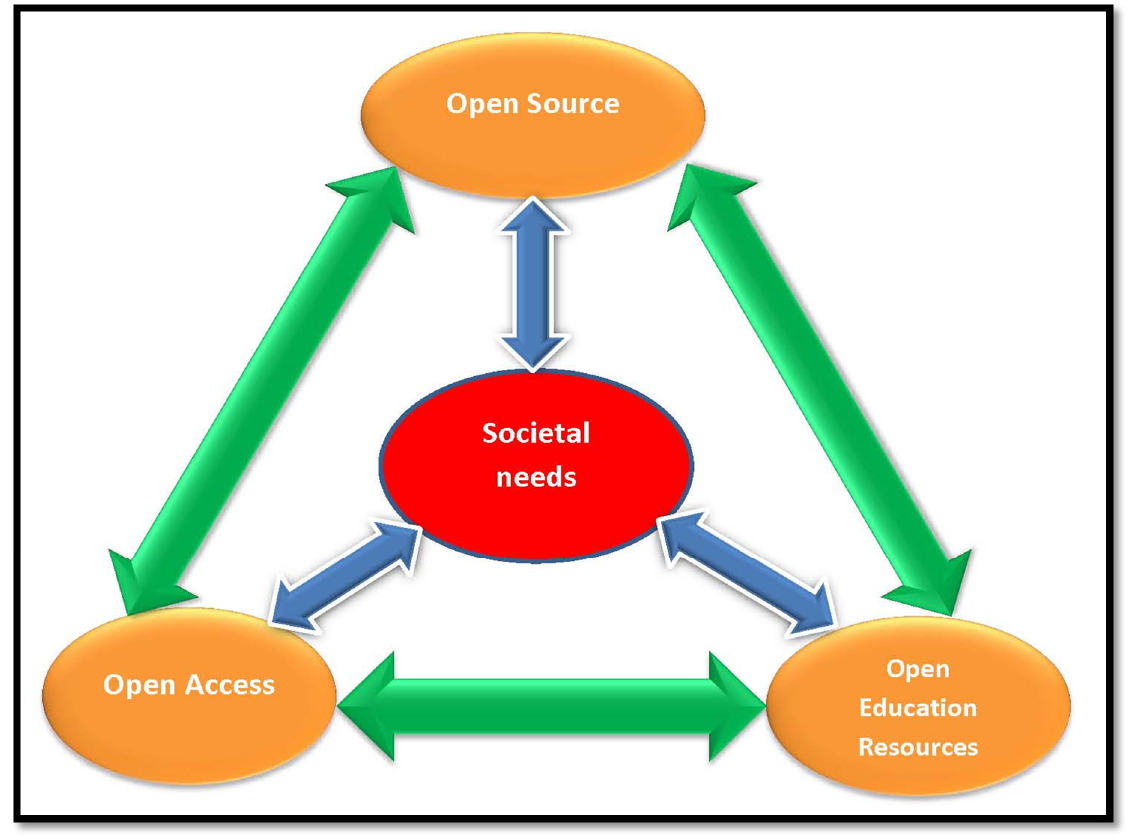
Figure 1. Societal benefits of open